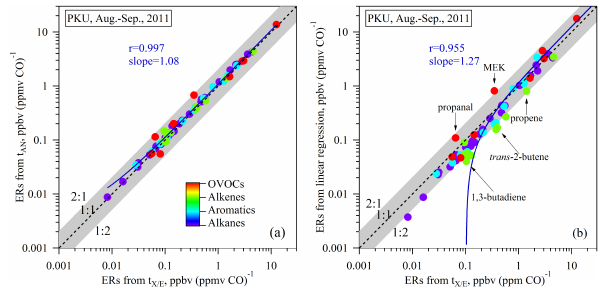
Figure 6. Emission ratios of individual VOC species calculated based on photochemical ages derived from o -xylene/ethylbenzene ( t X / E ) and compared with those obtained from (a) 2-BuONO 2 / n - butane ( t AN ) or (b) ODR linear regression of nighttime measure- ment data. Each data point represents an individual VOC species, which was colored VOC categories. The grey area represents the uncertainty range of ± 100%. The black dashed line and the blue solid line represent the 1:1 line and the best fit,